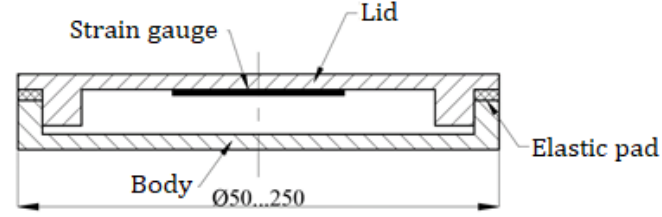
Figure 2. The design of the load cell for measuring stresses in the soil.